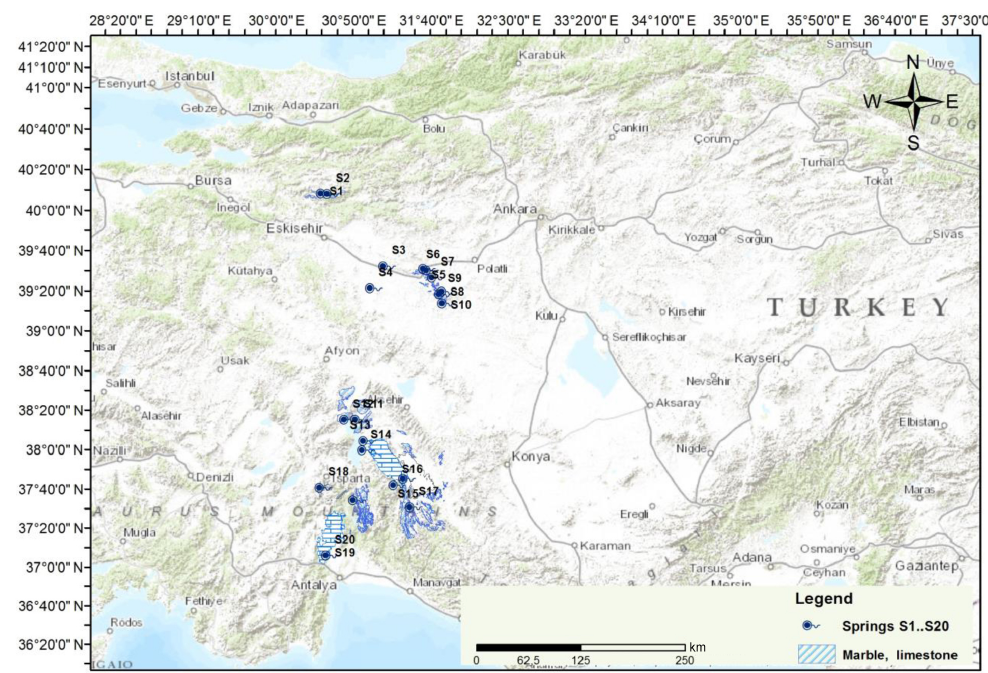
Figure 1. Location map of the study area and springs.